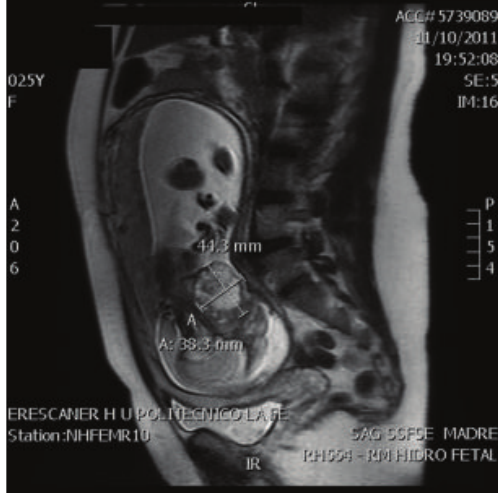
Figure 2: Nuclear magnetic resonance at 25 weeks, showing heterogeneous mass in cervical situation.